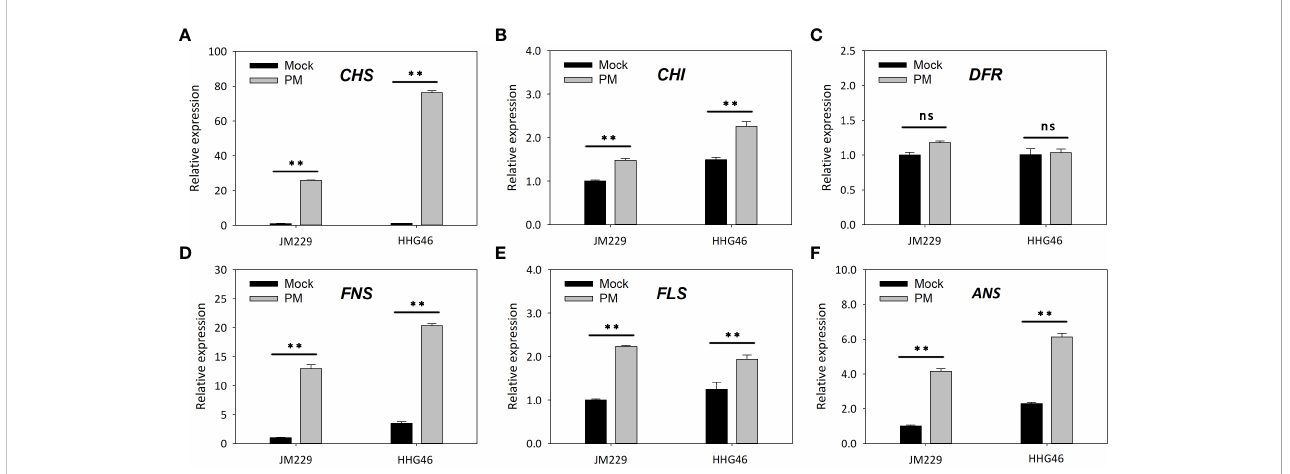
FIGURE 4 The effect of powdery mildew on the expression level of fl avonoids synthesis-related genes by quantitative reverse-transcription PCR analysis. Relative expression levels of (A) CHS , (B) CHI , (C) DFR , (D) FNS , (E) FLS , and (F) ANS in susceptible wheat cv. JM229 and resistant cv. HHG46. Error bars represent mean standard deviation of triplicate experiments. **, mean values differ signi fi cantly at the 1% probability level. ANS, anthocyanidin synthase; CHI, chalcone isomerase; CHS, chalcone synthase; DFR, dihydro fl avonol 4-reductase; FLS, fl avonol synthase; FNS, fl avone synthase; ns, not signi fi cantly different; PM, powdery mildew-inoculated